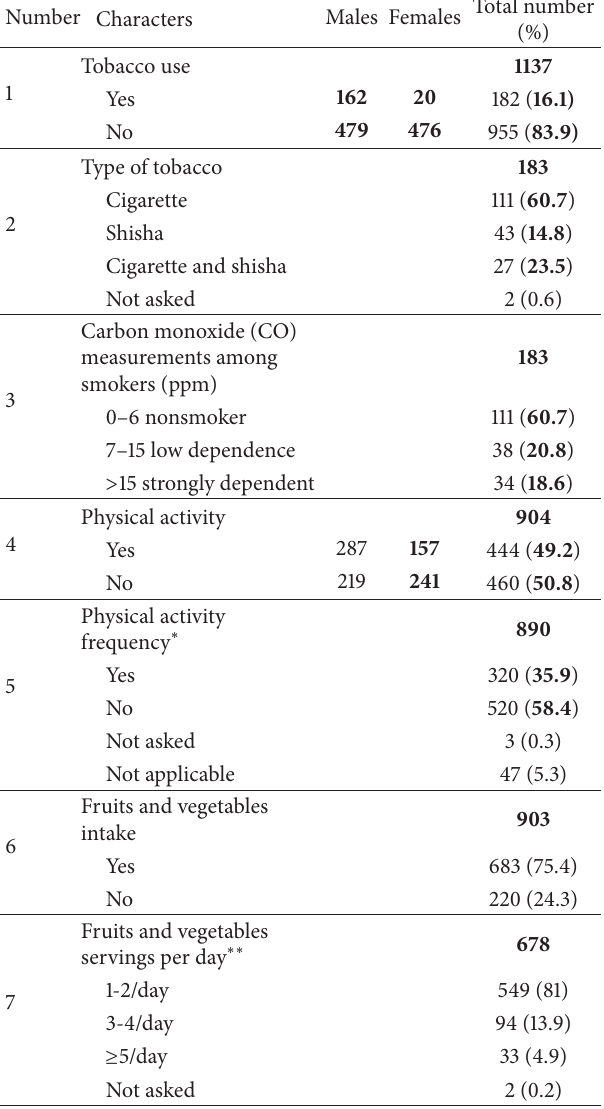
Table1:Thebehaviouralriskfactorsoftheparticipants(employees). Number